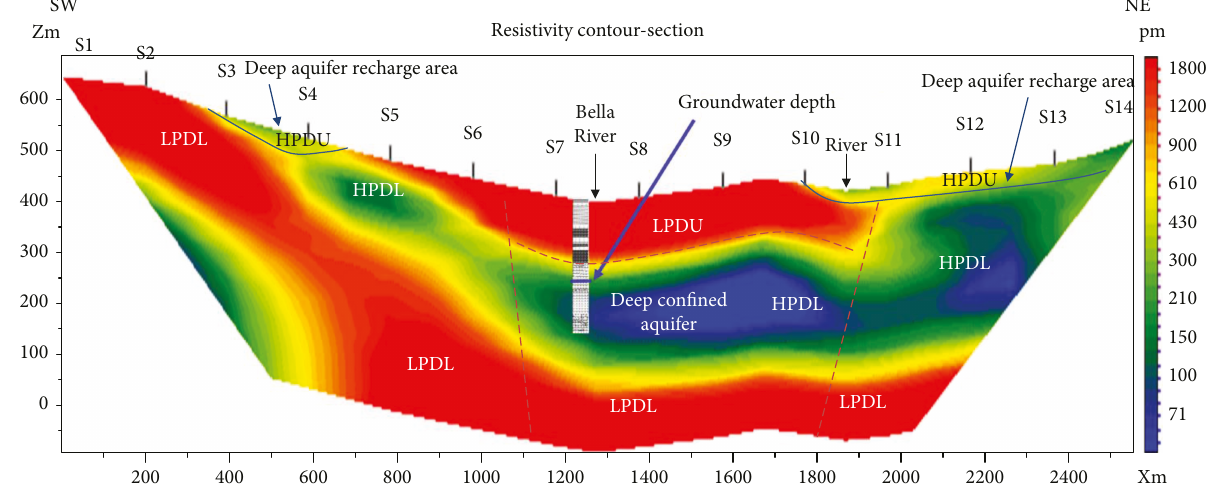
Figure 7: The well log applied on the DERT image. Red dotted lines are uncertain fault. HPDU=high permeability degree units; LPDU=low permeability degree units; HPDL=high permeability degree limestones; LPDU =low permeability degree